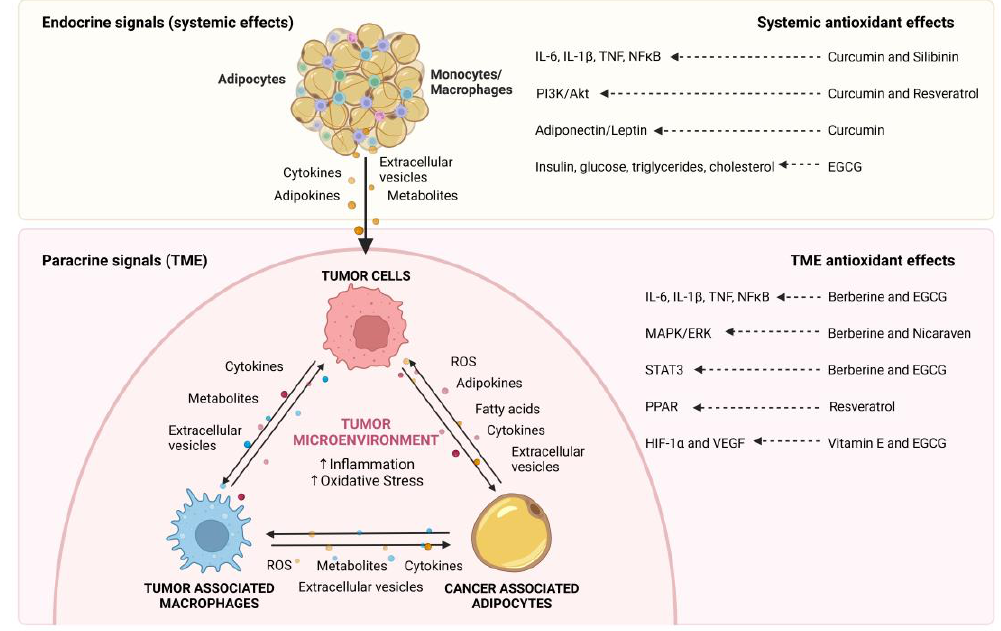
Figure 1. Endocrine and paracrine communication between adipocytes, macrophages, and cancer cells. Obesity-induced changes in the adipose tissue result in increased expression of cytokines, adipokines, metabolites, and extracellular vesicles (EVs) that influence cancer cell behavior and promote tumor development. In addition, in the tumor microenvironment (TME), adipocytes and macrophages are key components that interact with cancer cells by secreting a variety of signaling molecules, including, adipokines, cytokines, metabolites, fatty acids and EVs, which increase local inflammation and oxidative stress to generate a favorable microenvironment for tumor progression. Some antioxidants discussed in Section 5 and the pathways they control are also indicated.